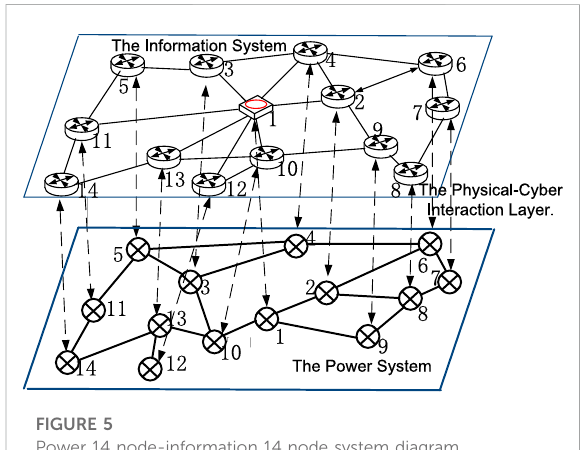
FIGURE 5 Power 14 node-information 14 node system